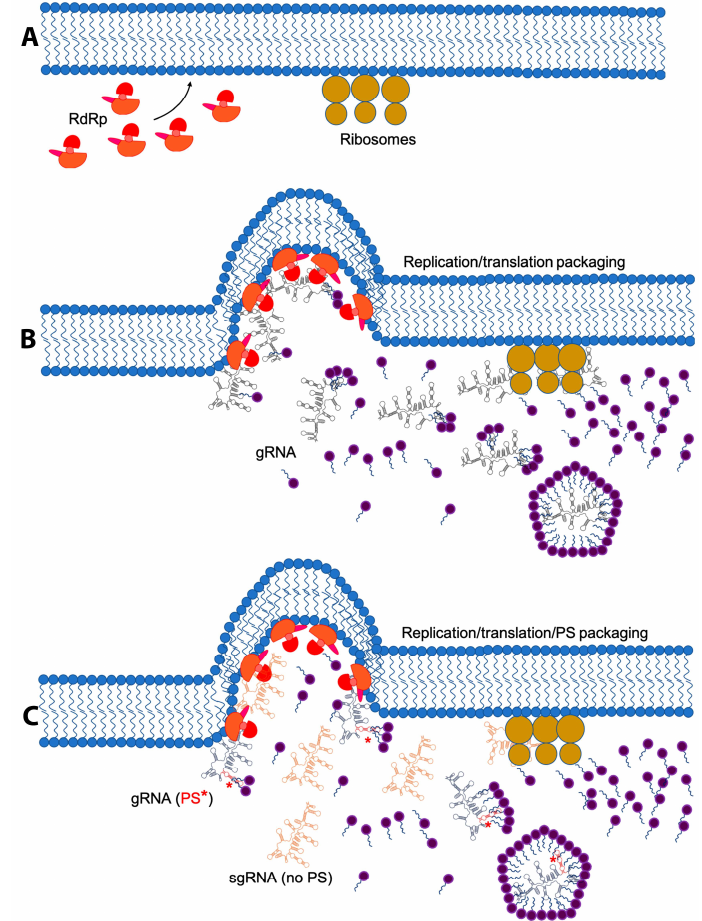
Figure 3. The role of RNA replication during RNA packaging. ( A ) Most RNA-dependent RNA polymerases (RdRp) of (+)ssRNA viruses interact with organelle membranes, creating viral assembly sites or replication factories. Sometimes these sites are very close to the ER. ( B ) There are viruses in which selective packaging seems to depend only on the ability of an RNA to be replicated by the RdRp (e.g., poliovirus). There is evidence that the ability of an RNA to act as a template for translation contributes to packaging selectivity (e.g., flock house virus). ( C ) In some other cases, the contribution of RNA replication is not sufficient, and the presence of a PS (red element with an *) is required for selective packaging. For example, in alphaviruses the presence of this signal is key to package only the genomic (blue with the PS in red with an *) but not the subgenomic RNA